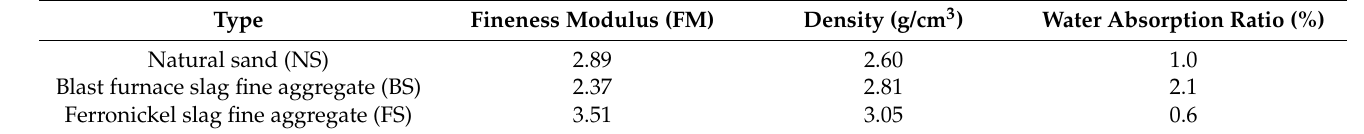
Table 2. Mix proportions of cement mortar.